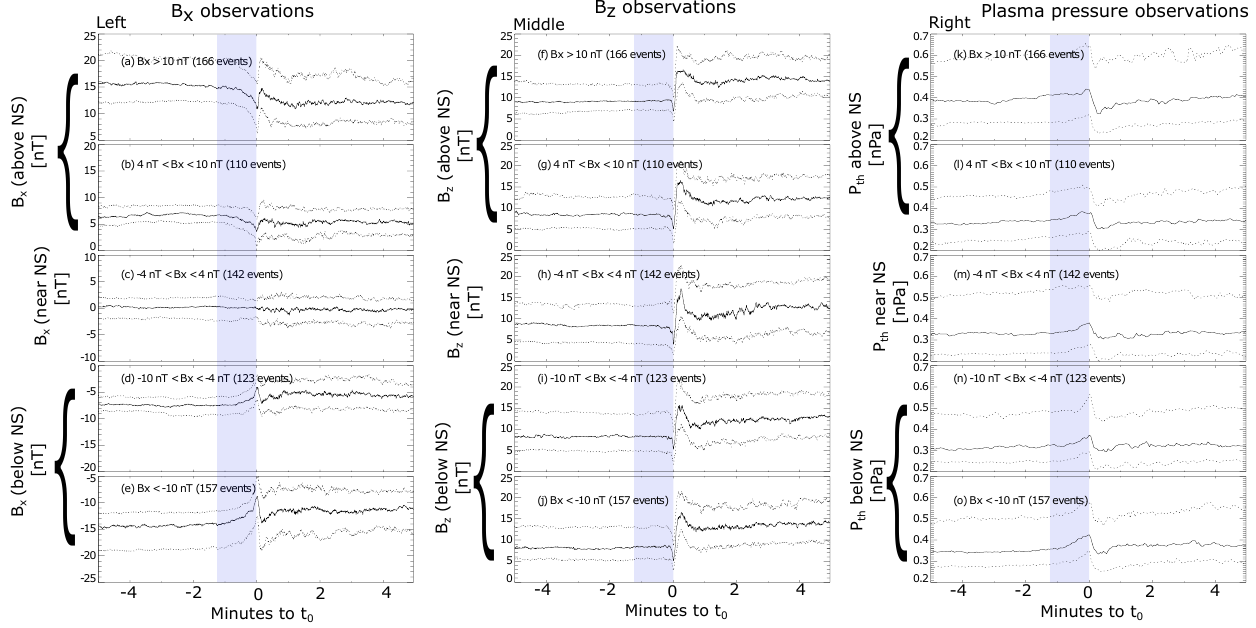
Figure 1. Superposed epoch analysis of the characteristics of DFs for B x (Left column), B z (Middle) and plasma pressure (Right). For each of the three columns, plotted from the top to bottom are the superposed results from DFs with background magnetic field B x > 10nT, 4nT <B x < 10nT, − 4nT <B x < 4nT, − 10nT <B x < − 4nT and B x < − 10nT. The three curves in each panel denote the upper quartile (dotted), median (solid), and lower quartile (dotted) of the superposed